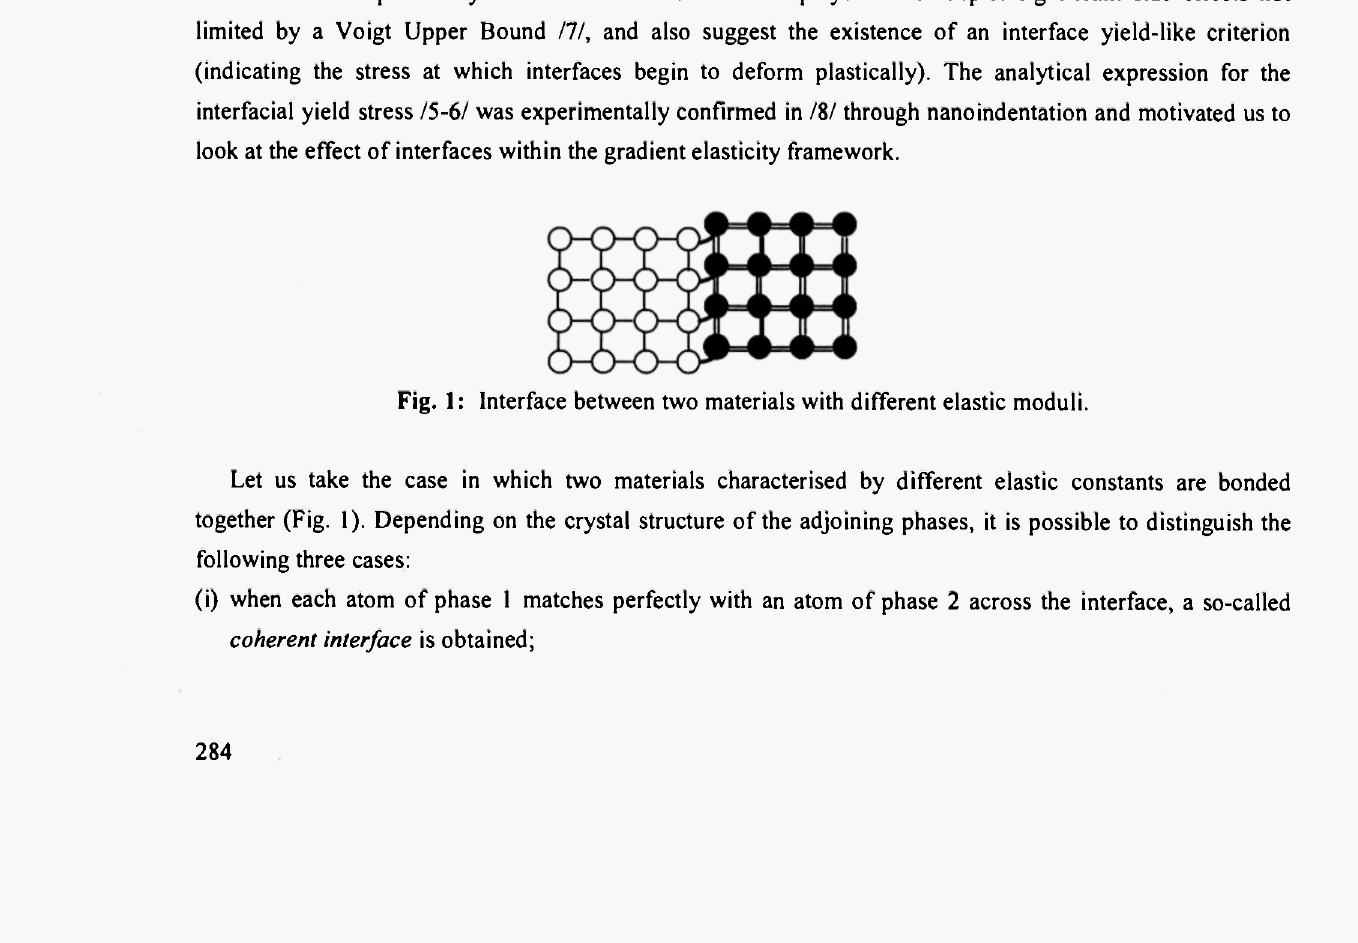
Fig. 1: Interface between two materials with different elastic